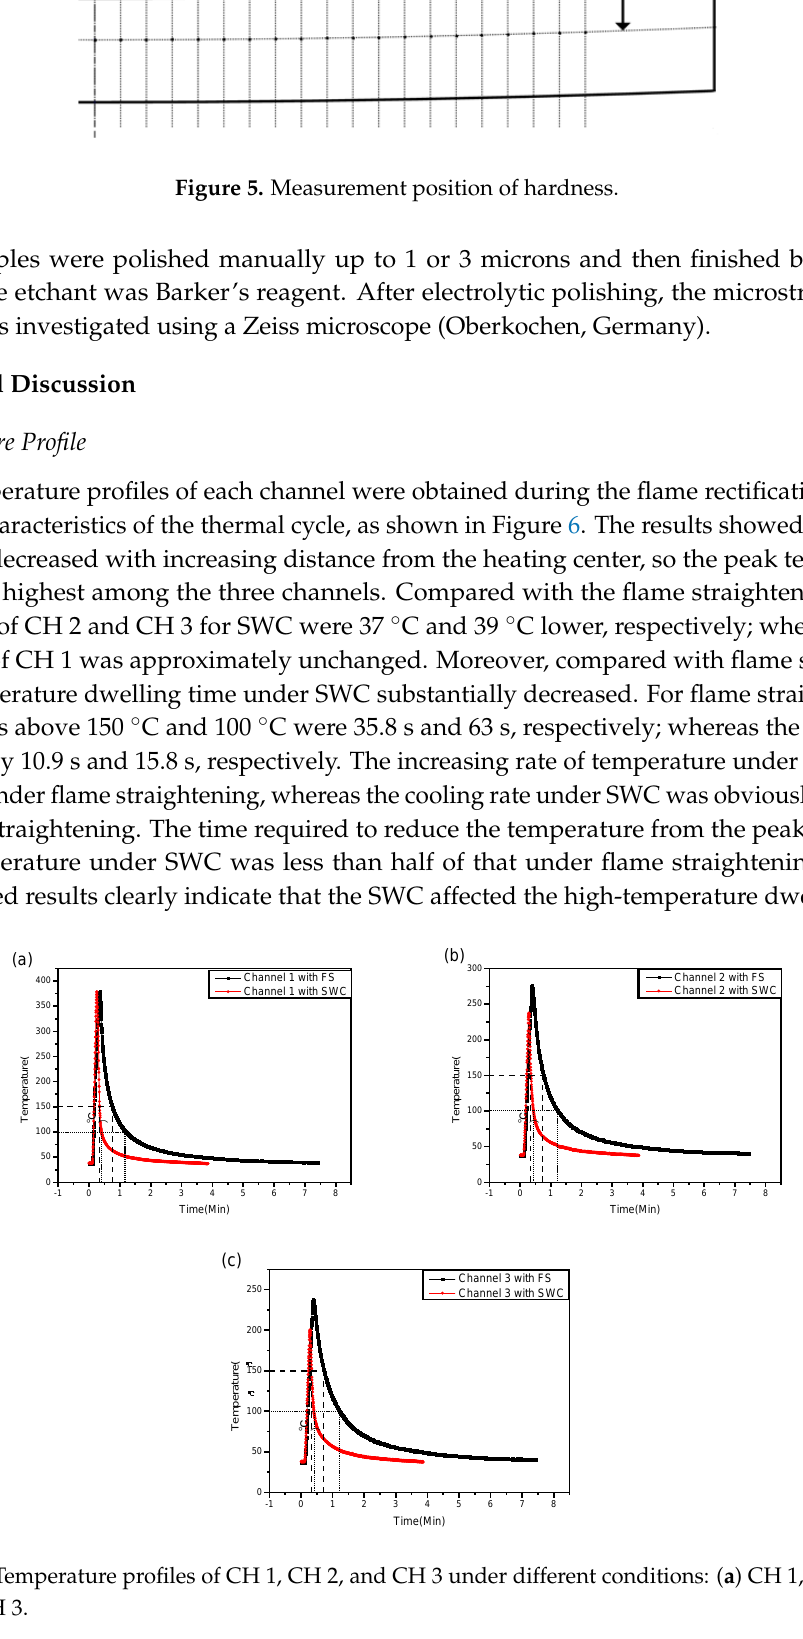
Figure 6. Temperature profiles of CH 1, CH 2, and CH 3 under different conditions: ( a ) CH 1, ( b ) CH 2, and ( c ) CH 3.